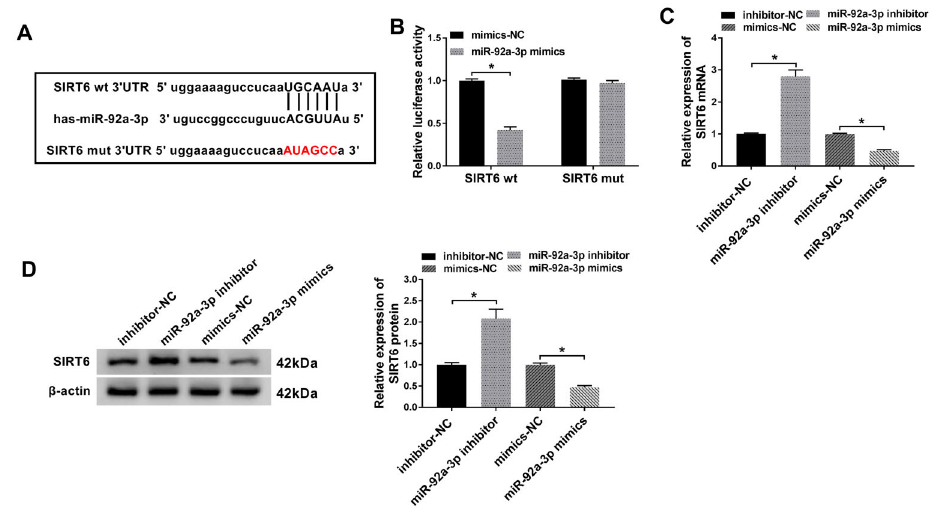
Figure 4. SIRT6 was a target of miR-92a-3p. A , Putative binding sites of miR-92a-3p on 3 ’ UTR of SIRT6. B , Luciferase activities were measured in human umbilical vein endothelial cells (HUVECs) co-transfected with SIRT6 wild type and mutant (wt/mut) luciferase reporter and miR-92a-3p mimics/miR-negative control (NC). C and D , Protein and mRNA levels of SIRT6 were assessed by RT-qPCR and western blot assays in HUVECs transfected with inhibitor-NC, miR-92a-3p inhibitor, mimics-NC, or miR-92a-3p mimics. Data are reported as means ± SD with three replicates. *P o 0.05